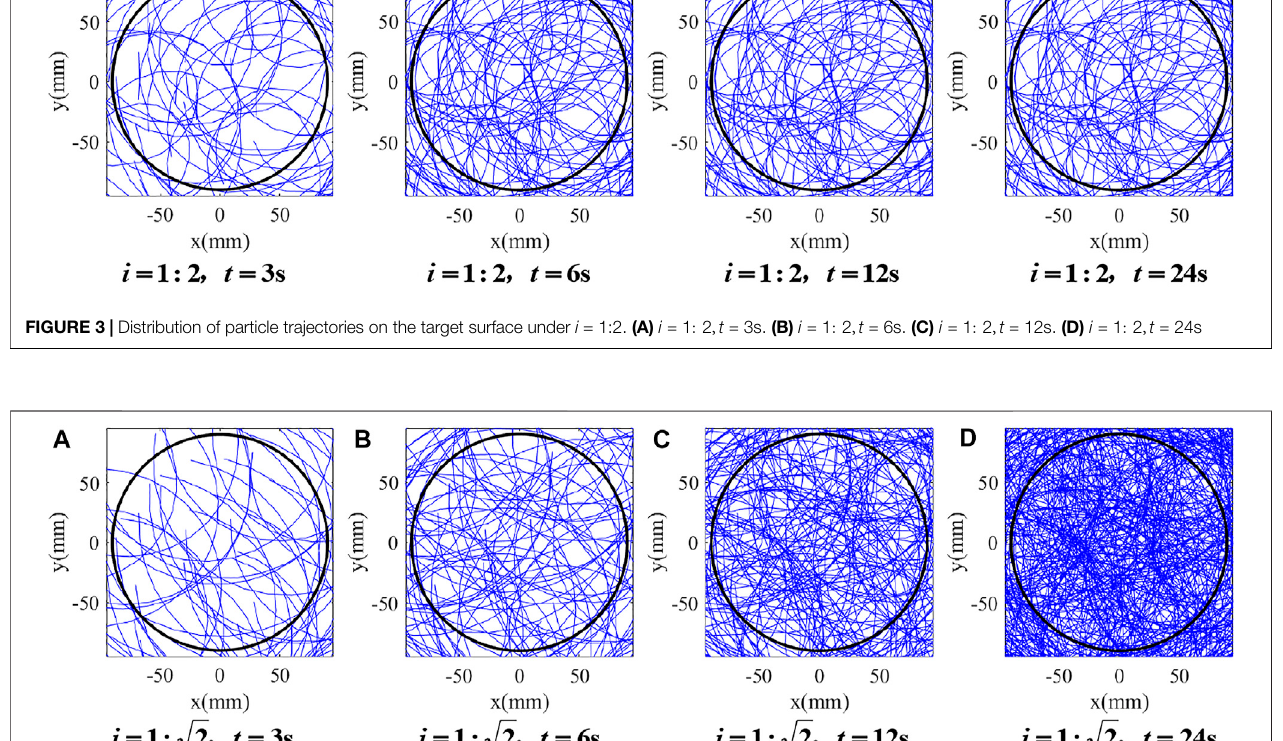
(cid:1)(cid:1) √ , t (cid:1) 6s. (C) i (cid:1) 1 : 2